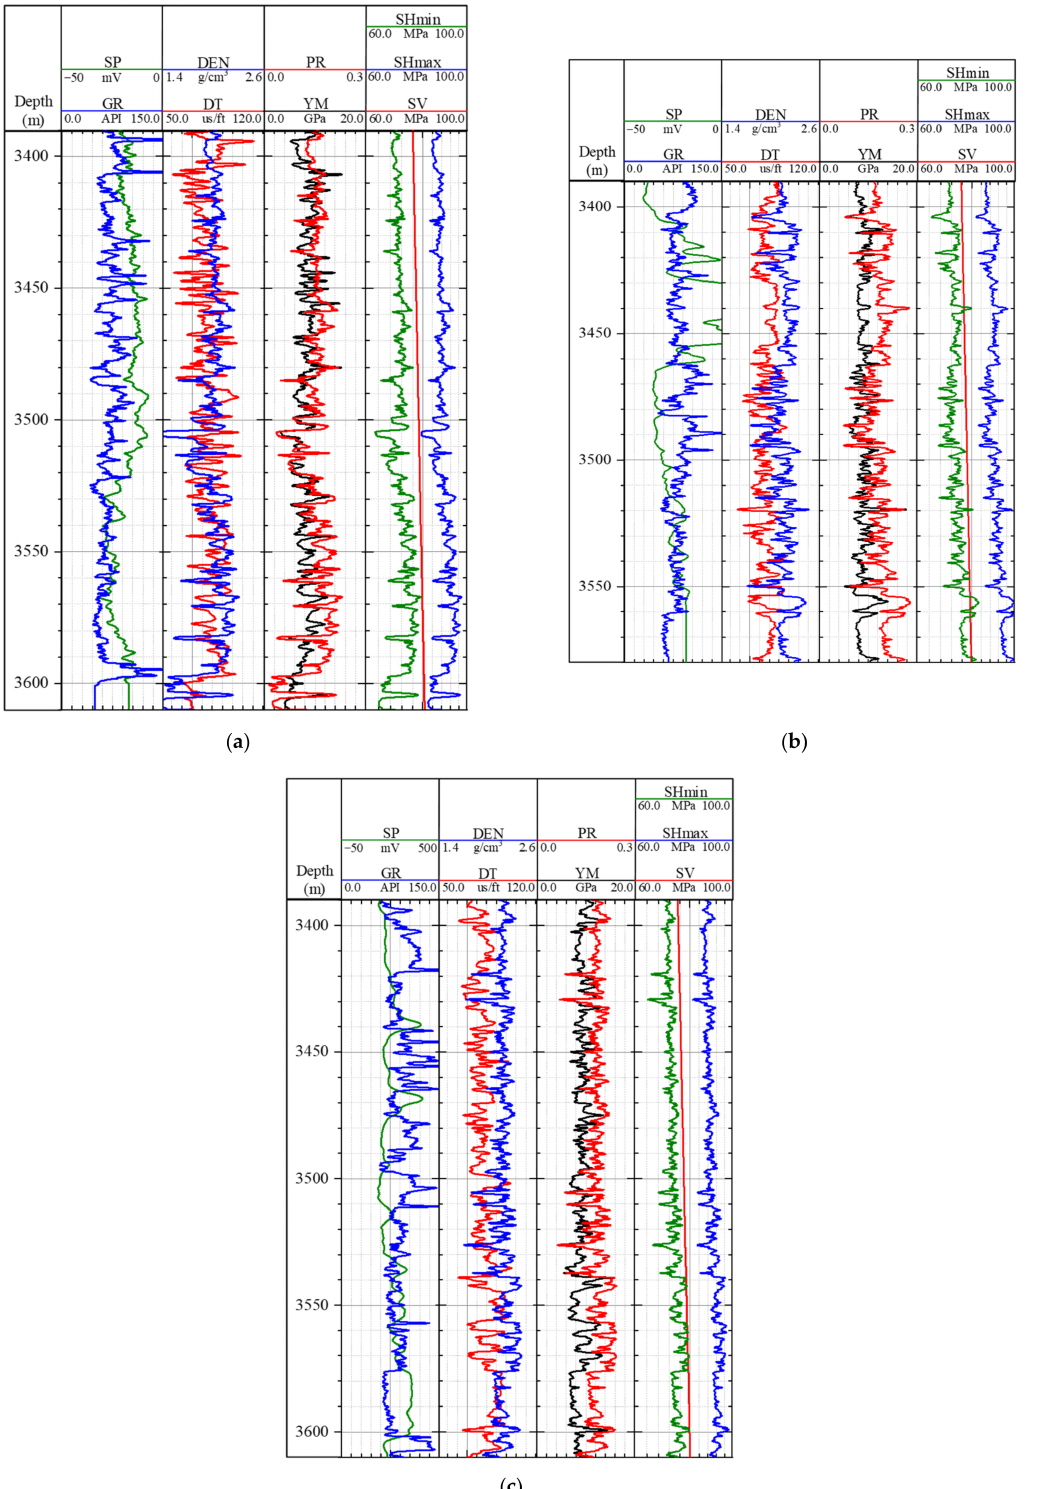
Figure 2. Well logging and geomechanical properties profile of the target wells. ( a ) Well #1. ( b ) Well #2. ( c ) Well